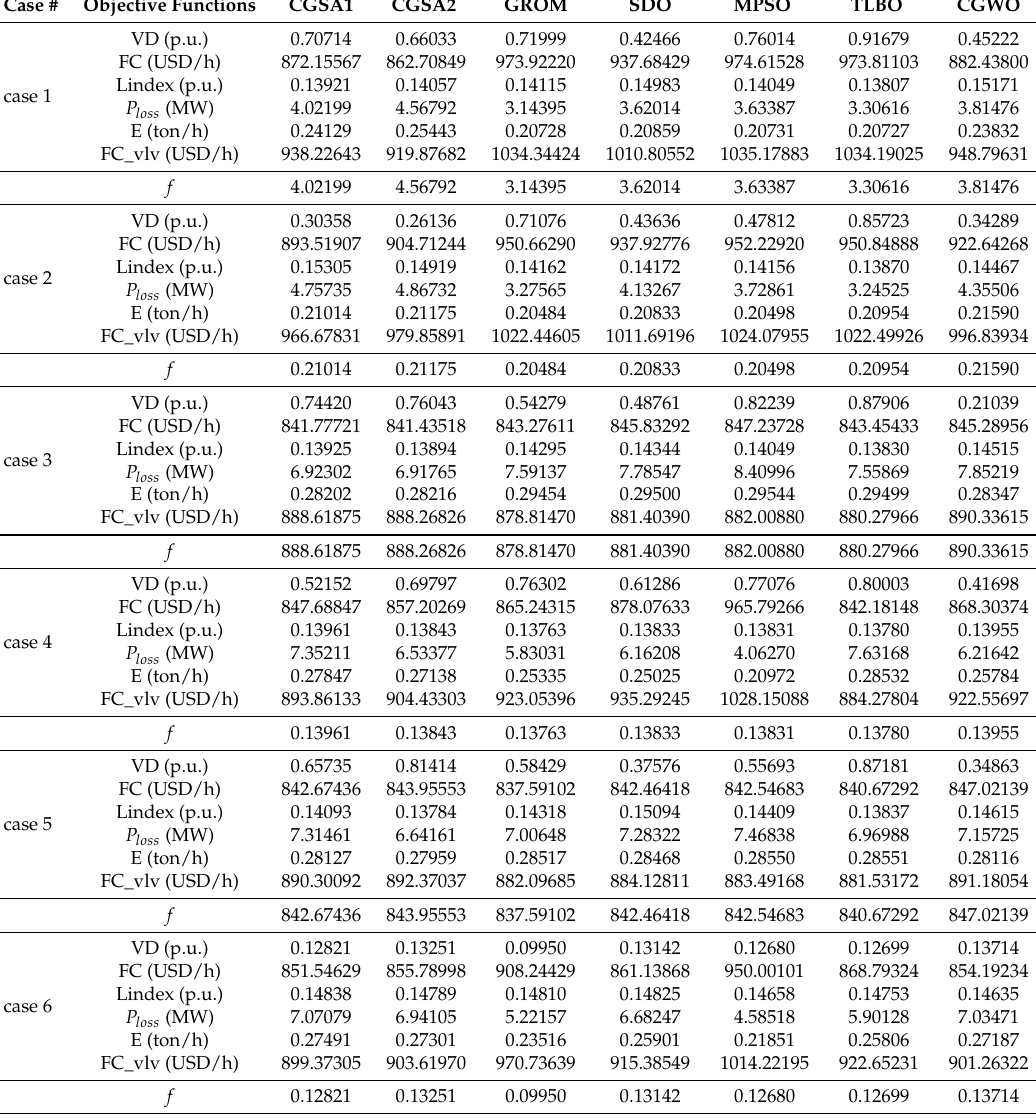
Table 5. Results of the GROM algorithm and other optimization algorithms for the single-objective OPF for IEEE 30-bus